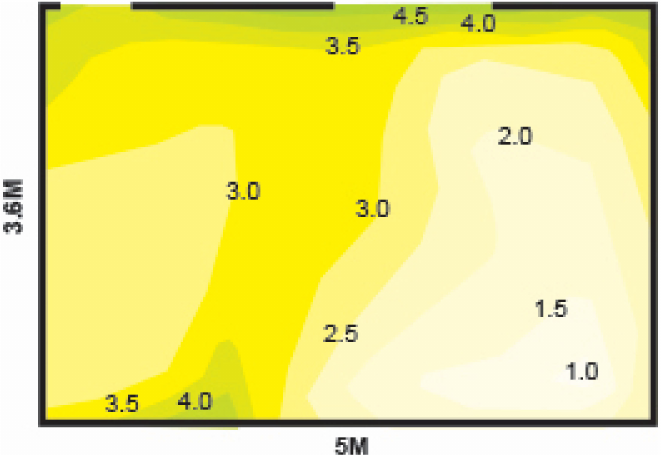
Figure 7. ACH = 5 times, average concentration: 2.06 pci (Max: 5.21 pci, Min: 0.93